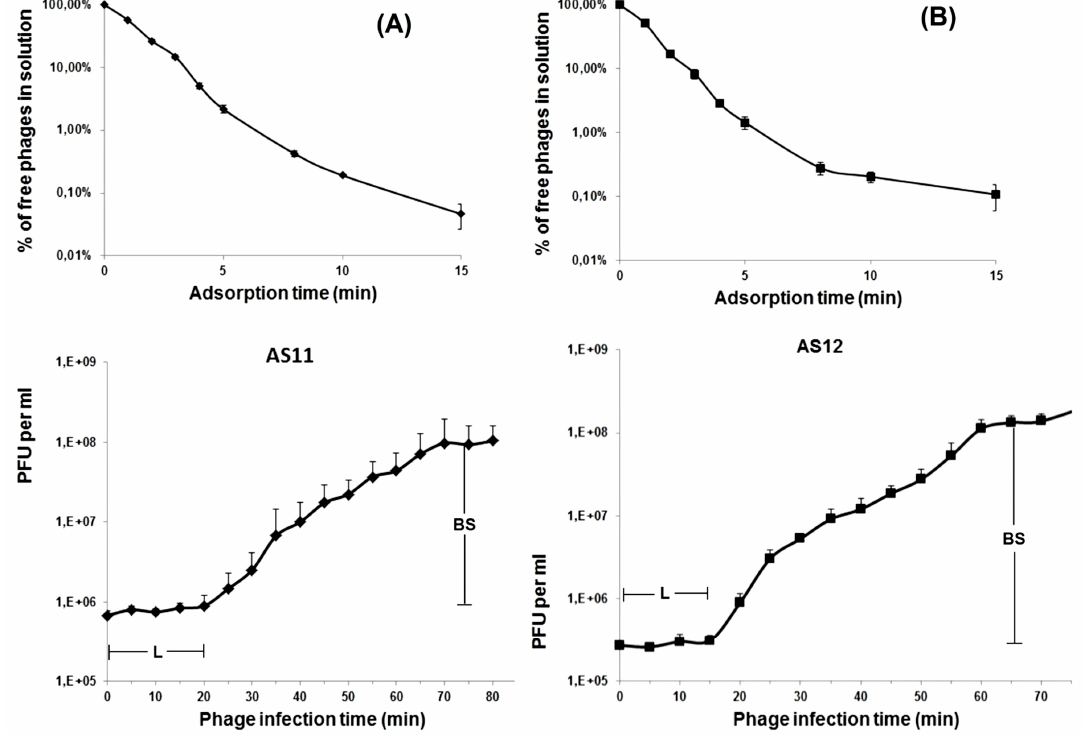
Figure 2. Infection analysis of phages AS11 and AS12. Adsorption assay and one-step growth curve of phage AS11 on A. baumannii strain 28 ( A ) and phage AS12 on A. baumannii strain 1432 ( B ) with indication of estimated burst size (BS) and latent period (L). Results are the means and standard deviations from three independent experiments. PFU: plaque forming units.